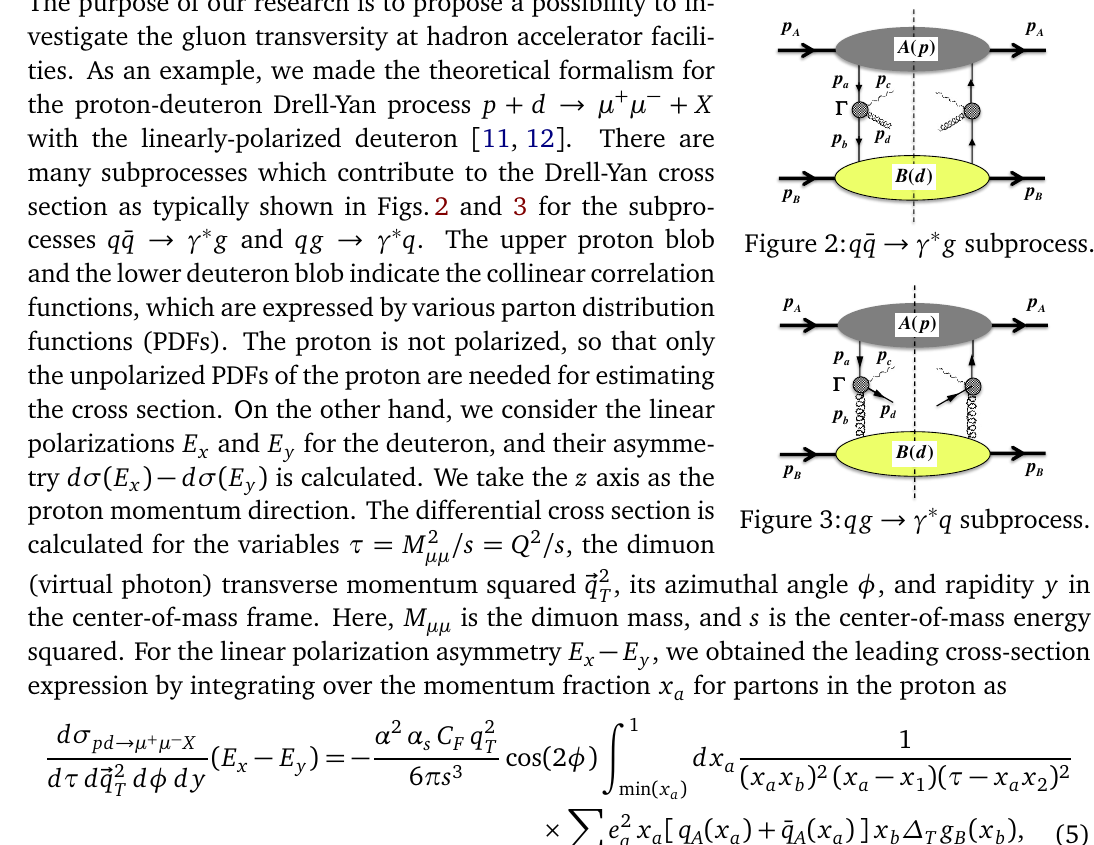
Figure 2: q ¯ q → γ ∗ g subprocess.